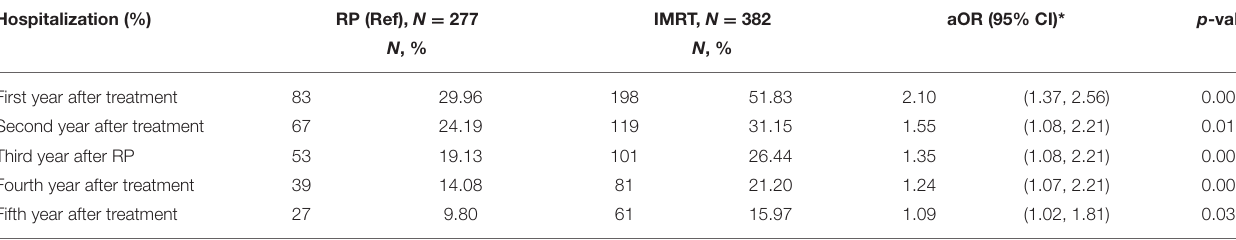
TABLE 2 | Logistic regression model of hospitalization for urinary diseases or treatment-related complications stratified by RP and IMRT. Hospitalization